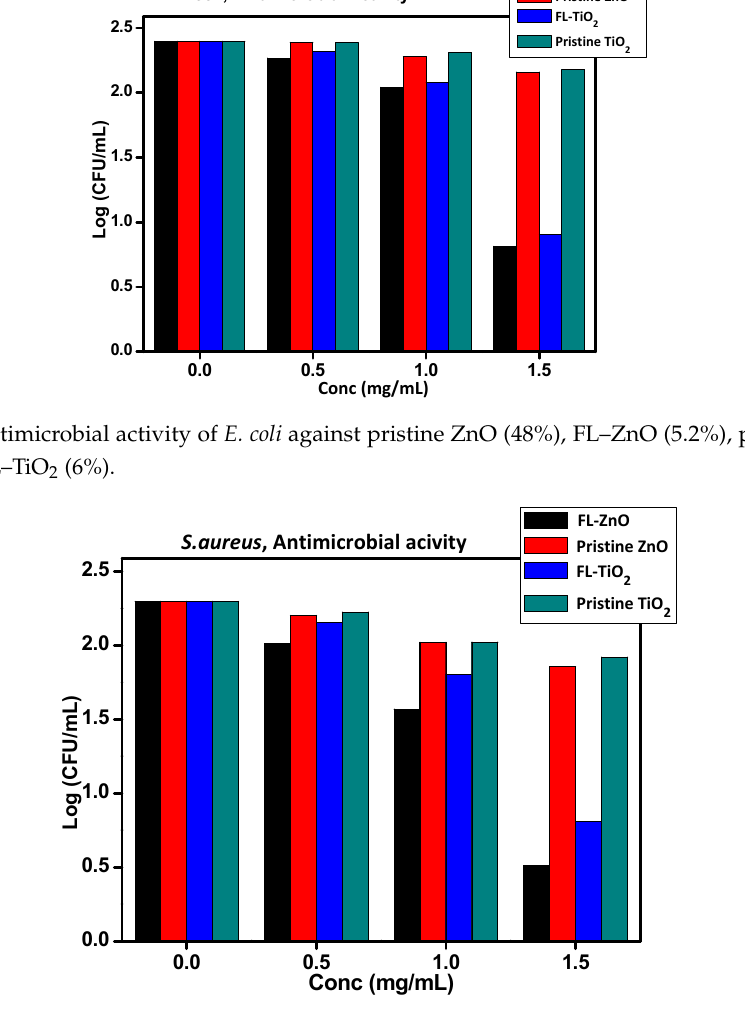
Figure 9. Antimicrobial activity of S. aureus against; growth shown for Pristine ZnO (32%), FL–ZnO (3.2%), Pristine TiO 2 (36%) and FL–TiO 2 (5%) .